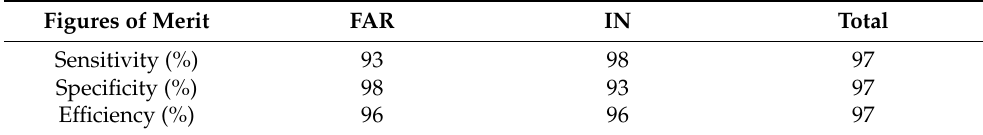
Figure 7. Whisker plots of the area of the LIBS atomic lines of some mineral nutrients detected in the root sections, considering the three main data acquisition location types (“FAR”—green color, “NEAR”—yellow color and “IN”—red color locations). Box represents data within the first and the third quartile, the dot symbol represents the mean value and lines extending parallel from the box represent the standard deviation. Horizontal gray band in the nitrogen (N) plot marks the mean and standard deviation of the signal measured on a pure copper sample. Table 2. PLS-DA classification figures of merit.